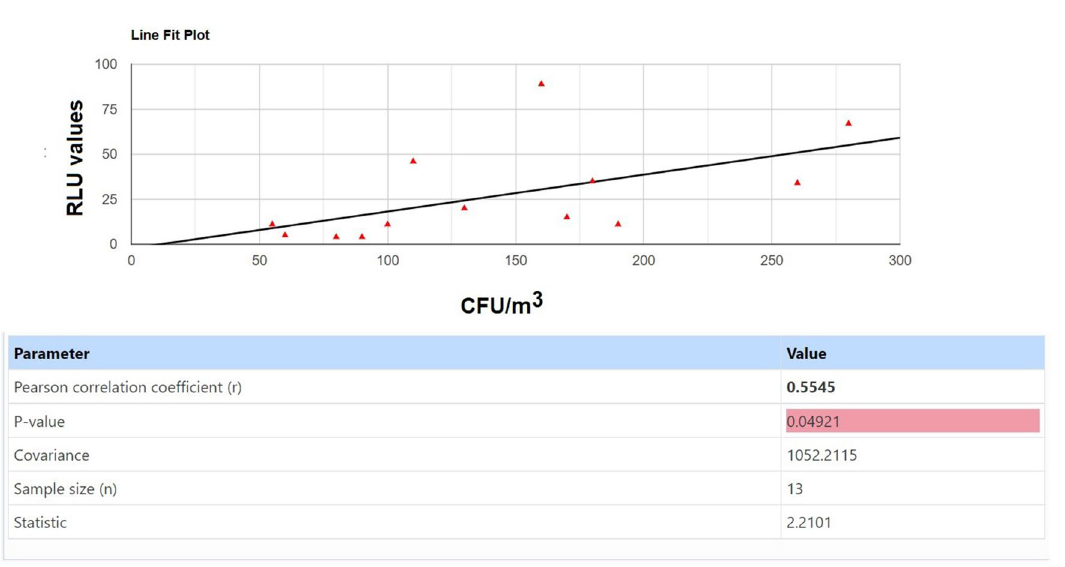
Figure 8. Pearson correlation of data collected for Fig. 4 by matching the relative delta between controls and TiO 2 –Ag–NP treated areas. See text for details.